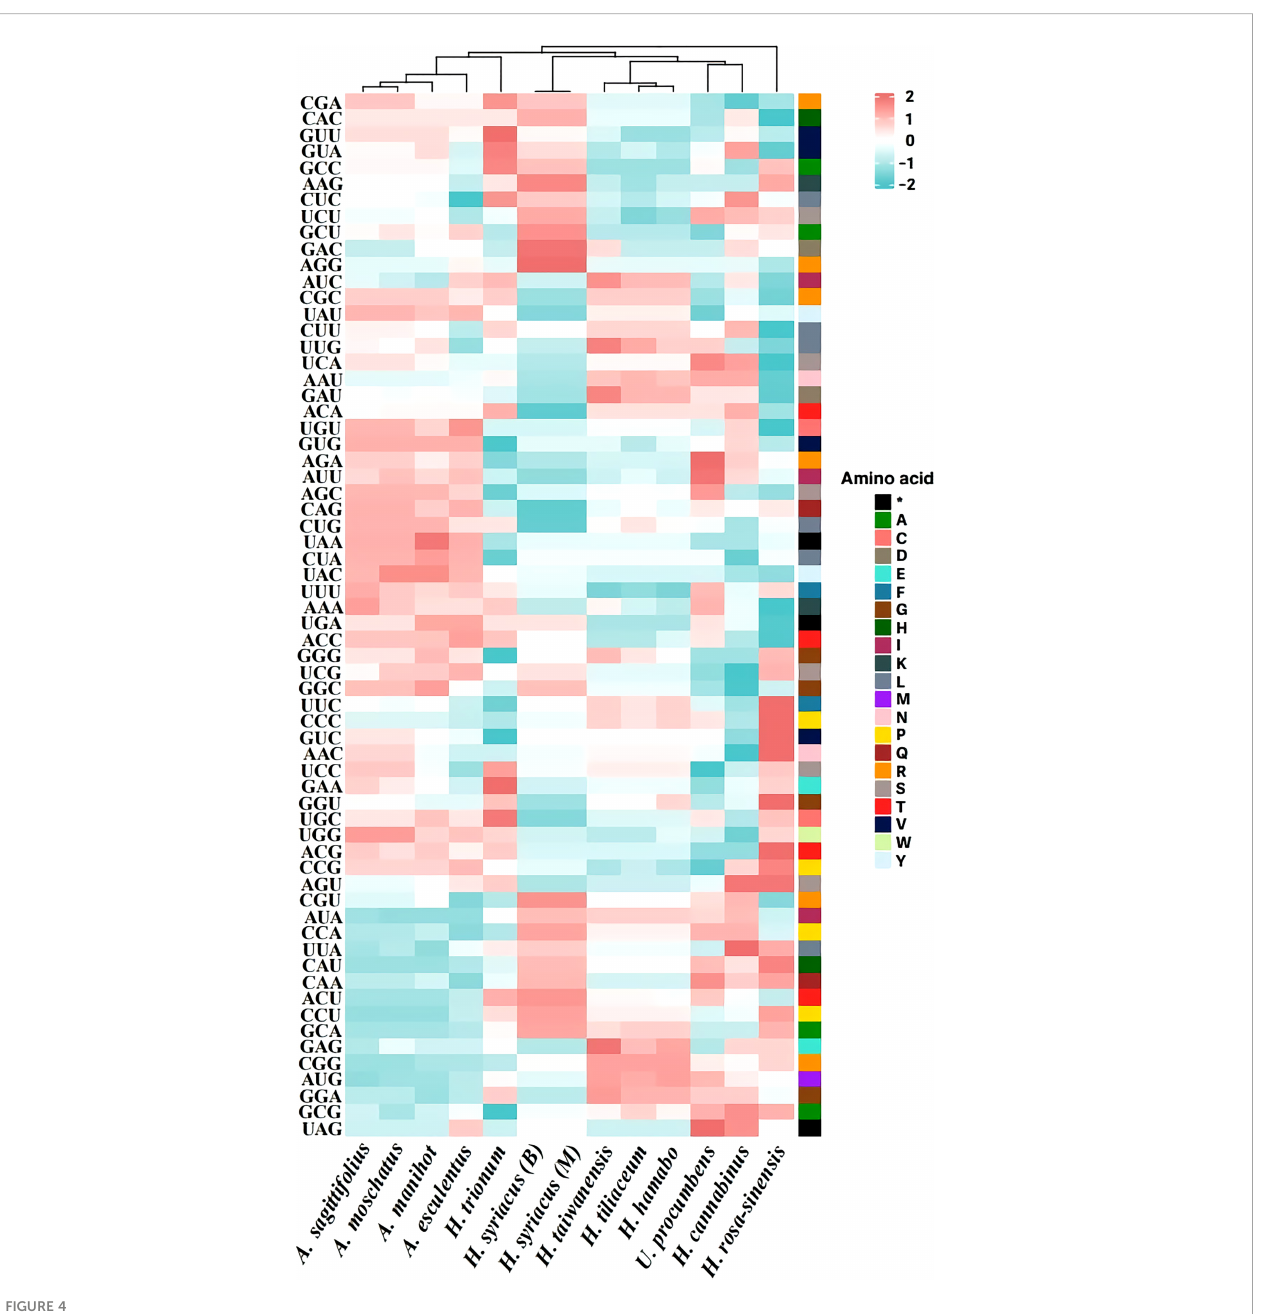
FIGURE 4 Relative synonymous codon usage (RSCU) pattern of chloroplast genes among 13 species of the tribe